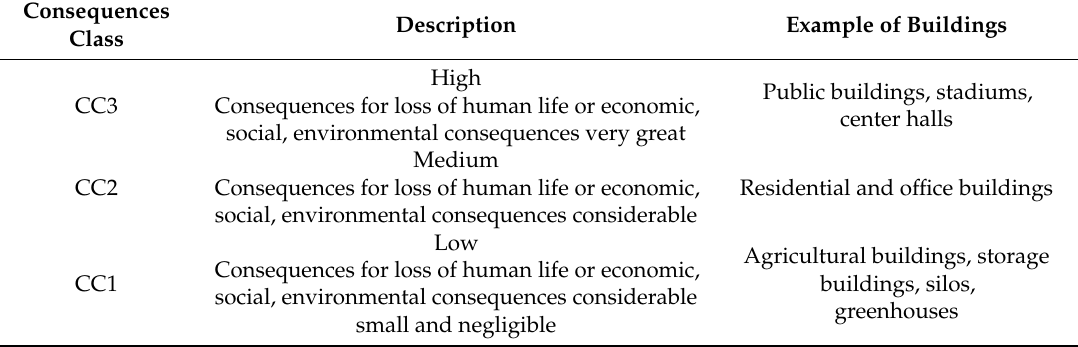
Table 1. Classes of consequences for buildings according to EN